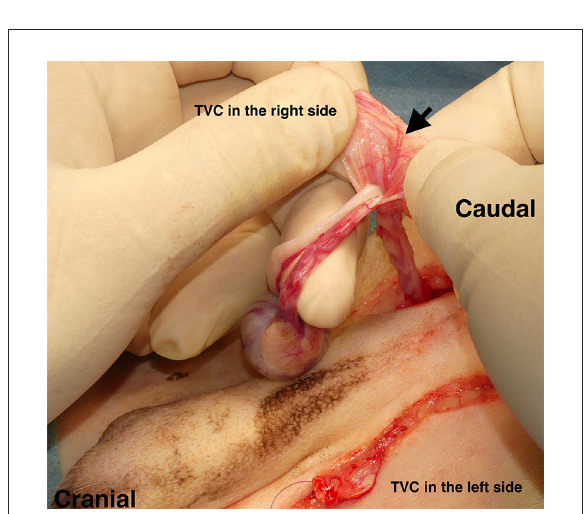
FIGURE2 Castration prior to perineal herniorrhaphy. Open castration was first performed by making an incision in the skin close to the inguinal region. After the open castration, the remaining tunica vaginalis communis (TVC) on each side was isolated with preserved blood flow. Black arrow: arteriole branches of the cremasteric